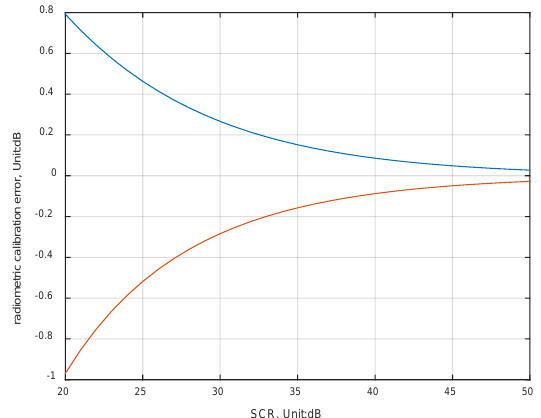
Figure 2. Upper (blue) and lower (red) limits of the radiometric calibration errors vs. signal-to-clutter ratio (SCR).